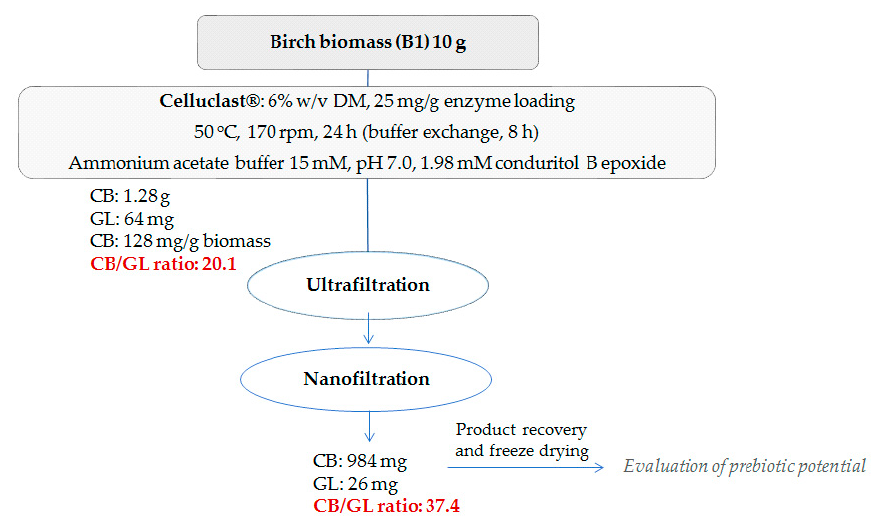
Figure 7. Overall scheme of the cellobiose production from pretreated birch.